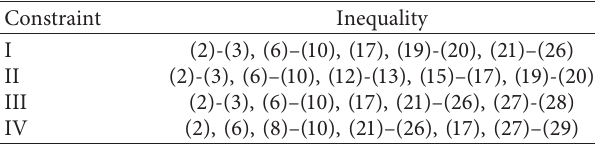
Table 5: Constraint